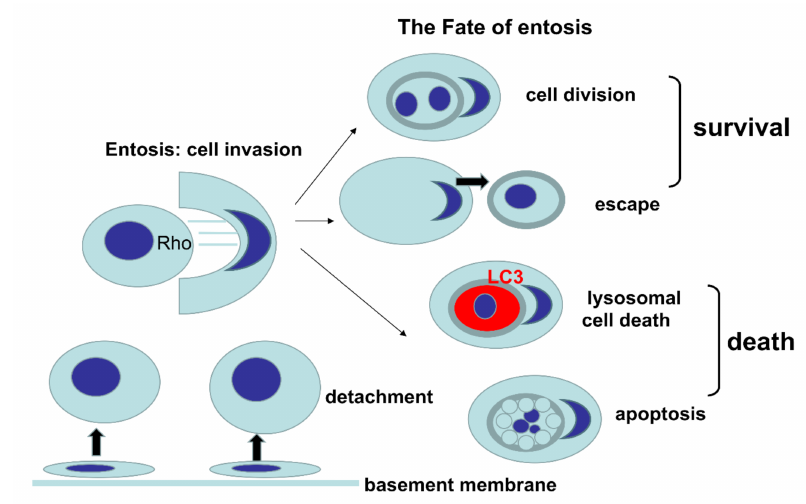
Figure 1. Graphical presentation of various fates of